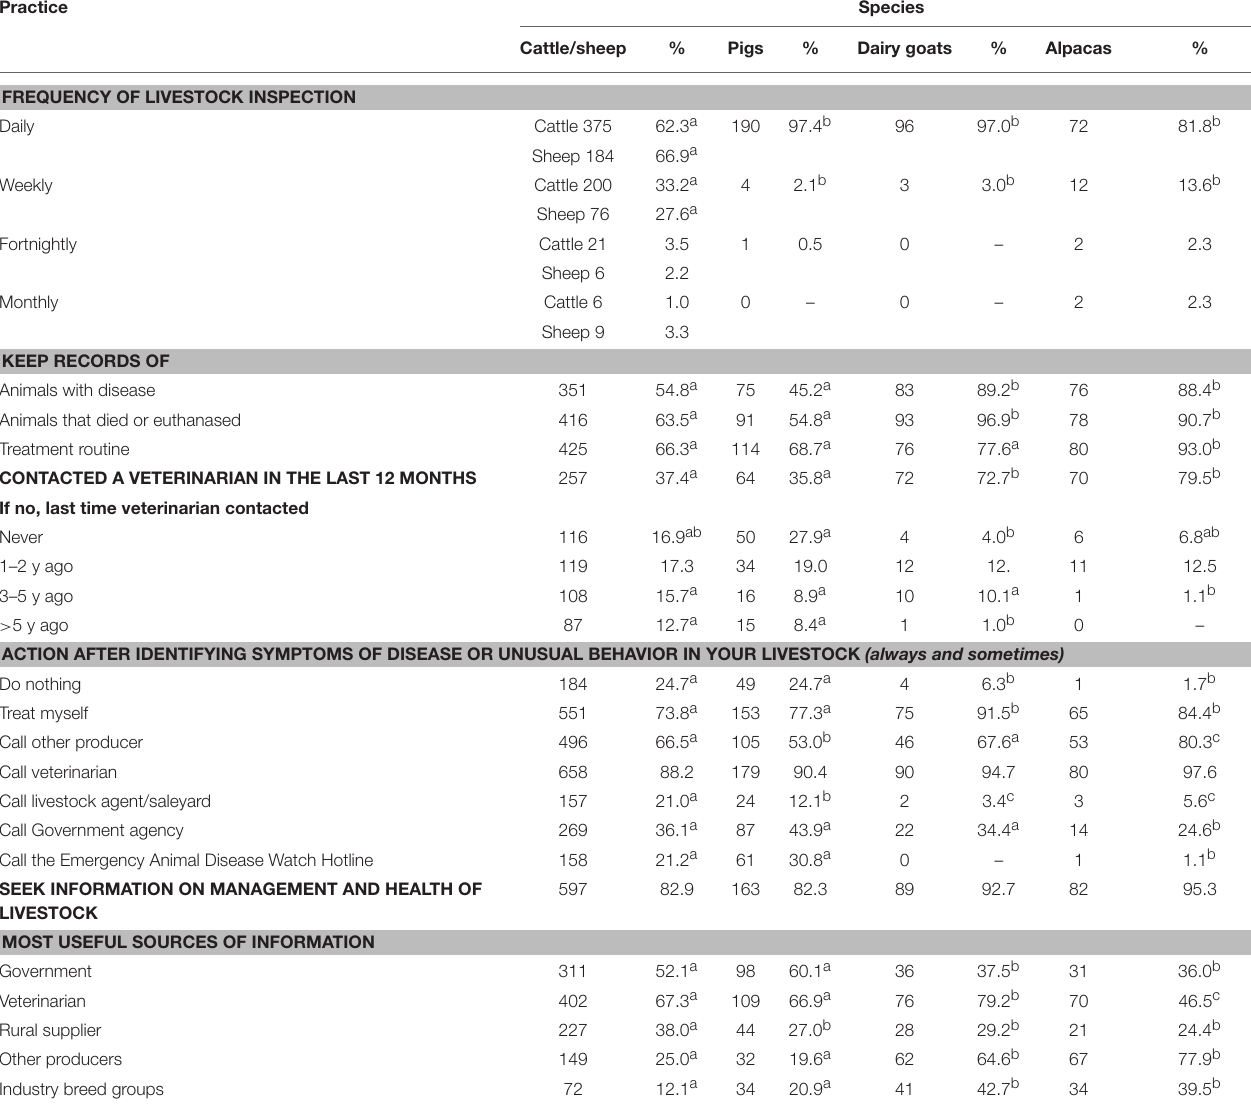
TABLE 2 | Animal health management practices of 1,140 smallholder livestock producers participating in a cross-sectional study in Australia in 2013–2015.